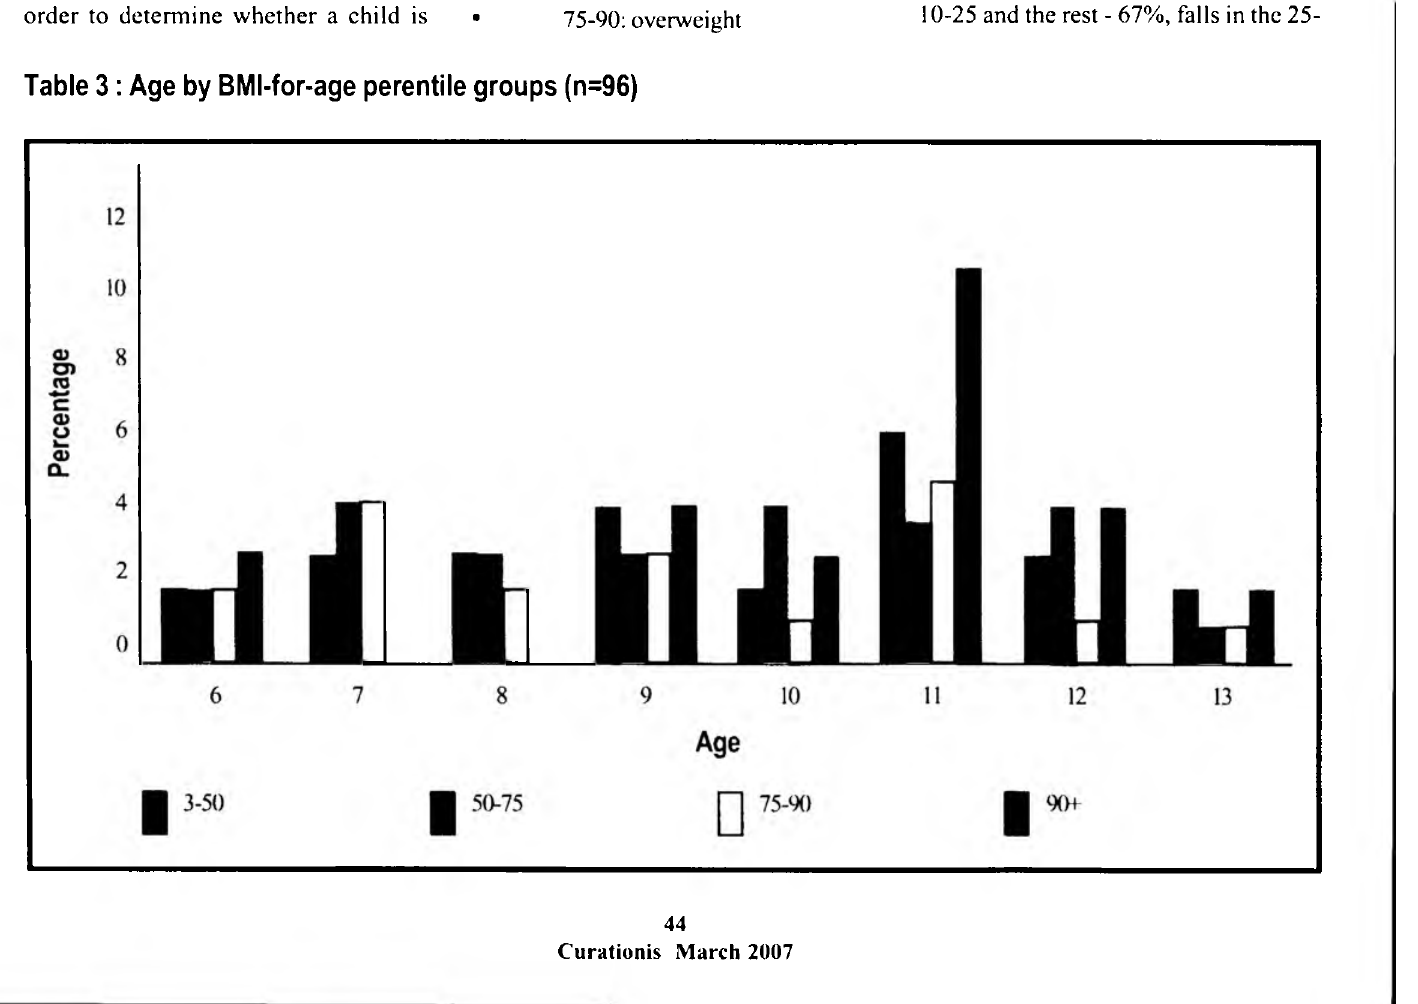
Table 3: Age by BMI-for-age perentile groups